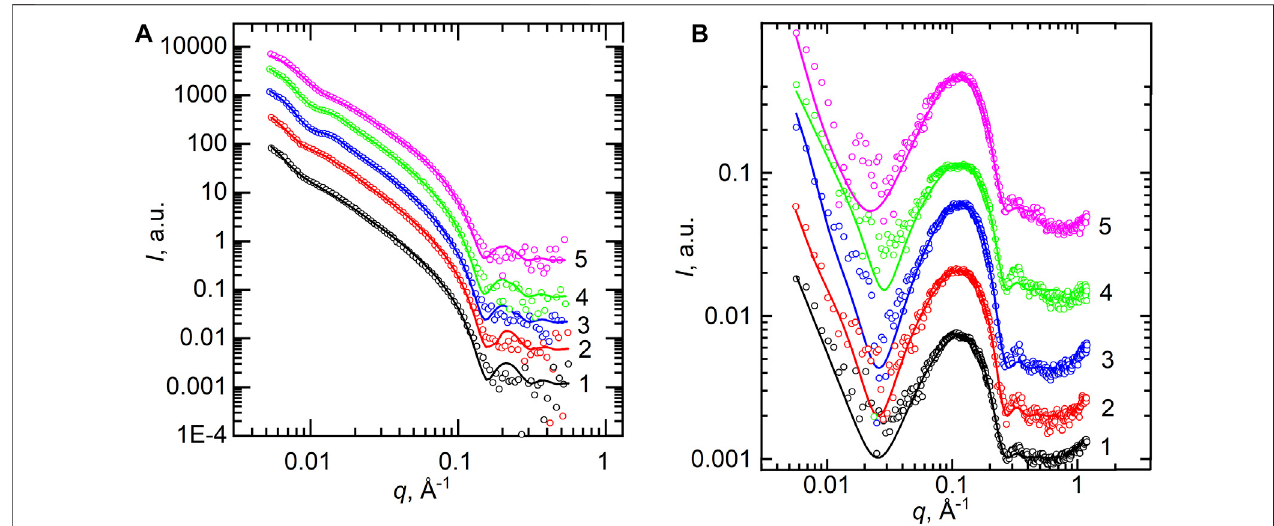
FIGURE 3 | (A) SANS experimental curves measured at T = 25 ° C for POPC samples (points) and the best- fi t results of their model analysis by spherical vesicles (lines). (B) SAXS curves measured at T = 25 ° C for POPC (points) and their best- fi t results of the Gaussian model (lines). SANS and SAXS curves are presented for 0 mM (1), 1 mM (2), 5 mM (3), 10 mM (4), and 50 mM (5) of Ca 2+